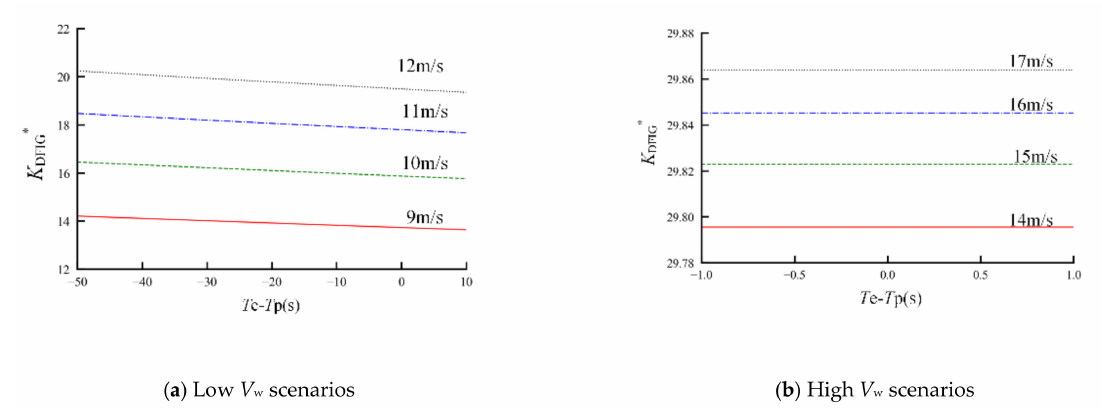
Figure 6. The K DFIG with di ff erent ( T e − T p ) under di ff erent wind speeds, ( a ) for low wind speeds, ( b ) for high wind speeds.